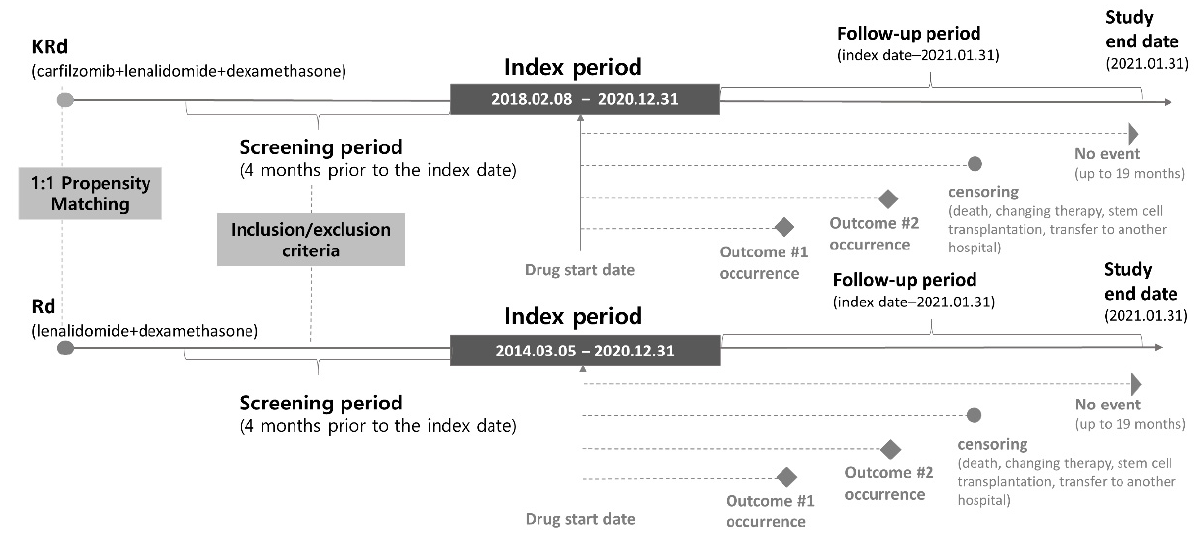
Figure 1. Flow diagram of safety analyses of KRd and Rd in relapsed/refractory multiple myeloma patients. KRd—combination regimen of carfilzomib, lenalidomide, and dexamethasone; Rd—combination regimen of lenalidomide and dexamethasone.